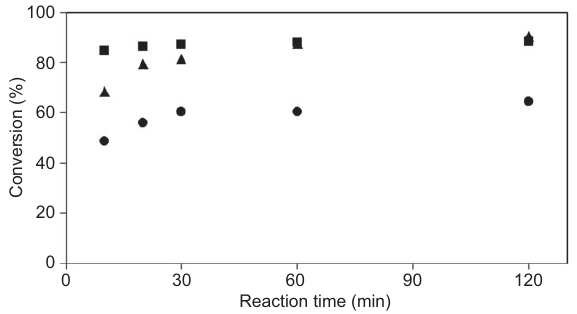
Figure 1 Effect of different types of ILs on the oxidative conversion of cinnamyl alcohol [3 mol% VO(acac) (cid:2) , [bmim][Tf N]; (cid:2) , [bmim][TfO]; (cid:3) , [bmim][NO 2